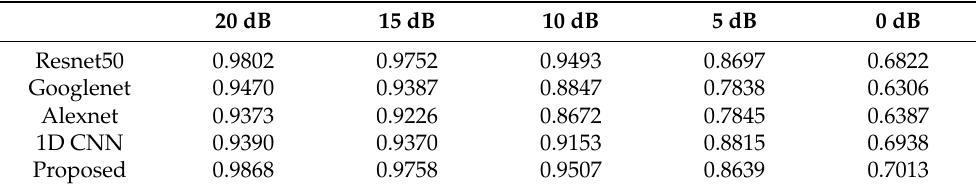
Figure 10. The classification performance for different methods.